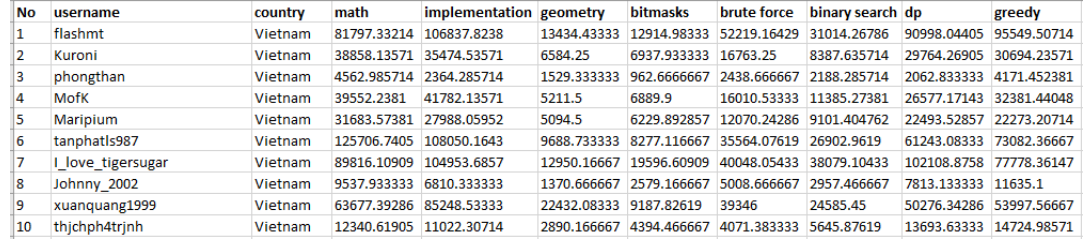
Figure 4. The scores of 8 skills of the top 10 users in Vietnam.